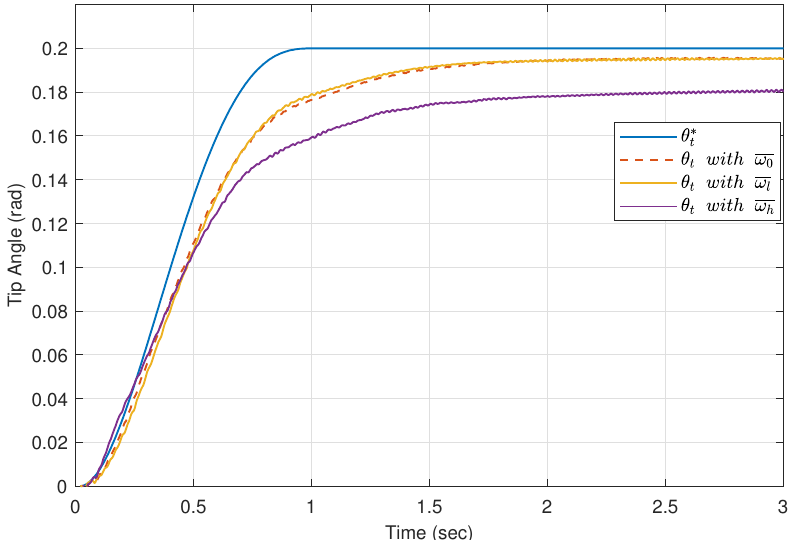
Figure 13. Experimental tracking of a trajectory using the PD controller (45).